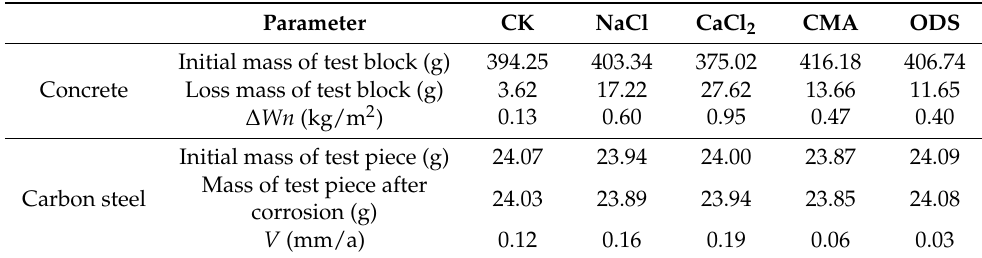
Table 3. Corrosion results of concrete and carbon